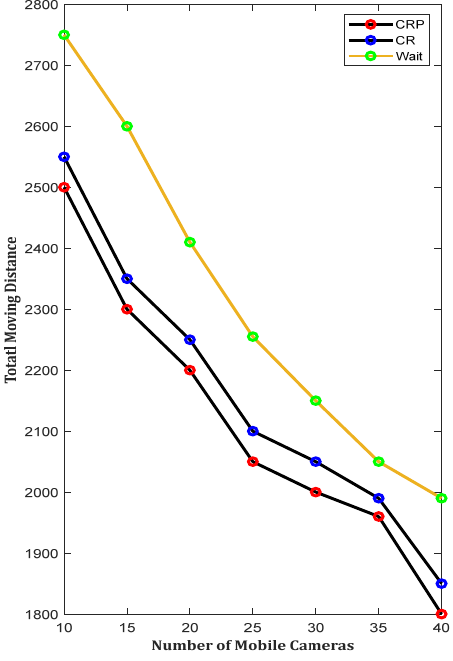
Figure 8. Total moving distance vs. number of mobile cameras.